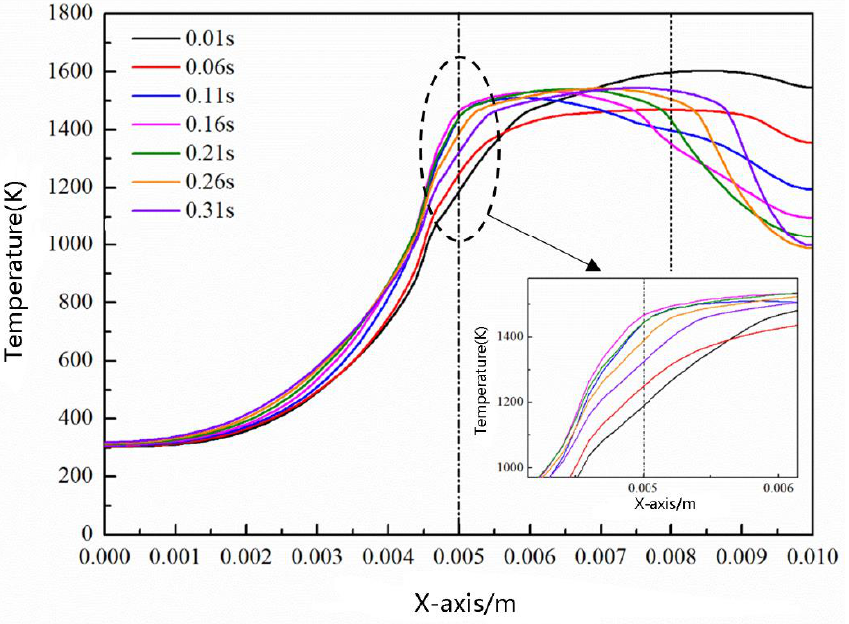
Figure 16. The temperature change on the symmetry line of the first deposition surface.